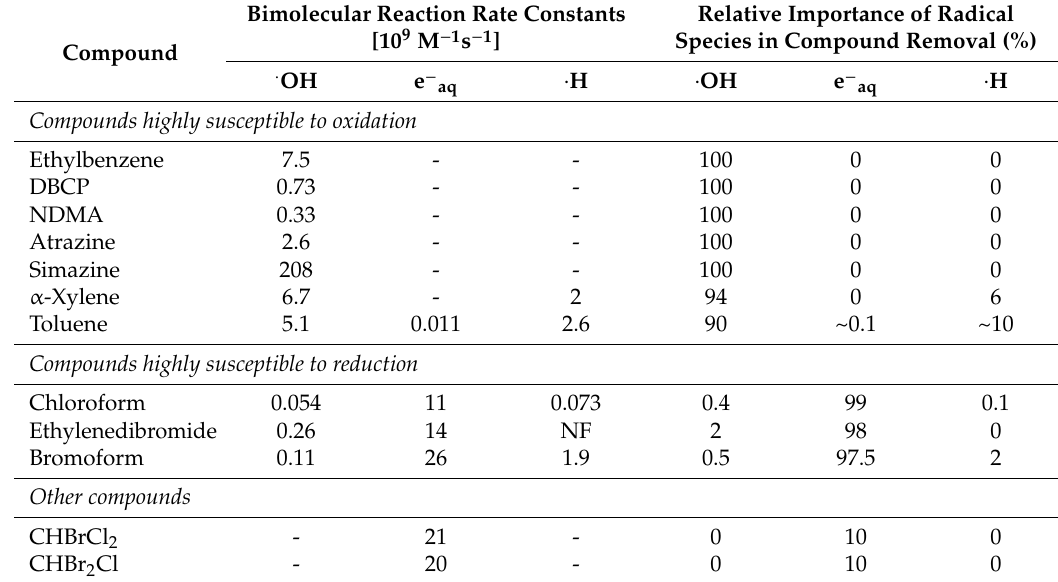
Table 3. Organic compounds’ removal rates by di ff erent radicals, and the relative importance of each species in the process (modified from